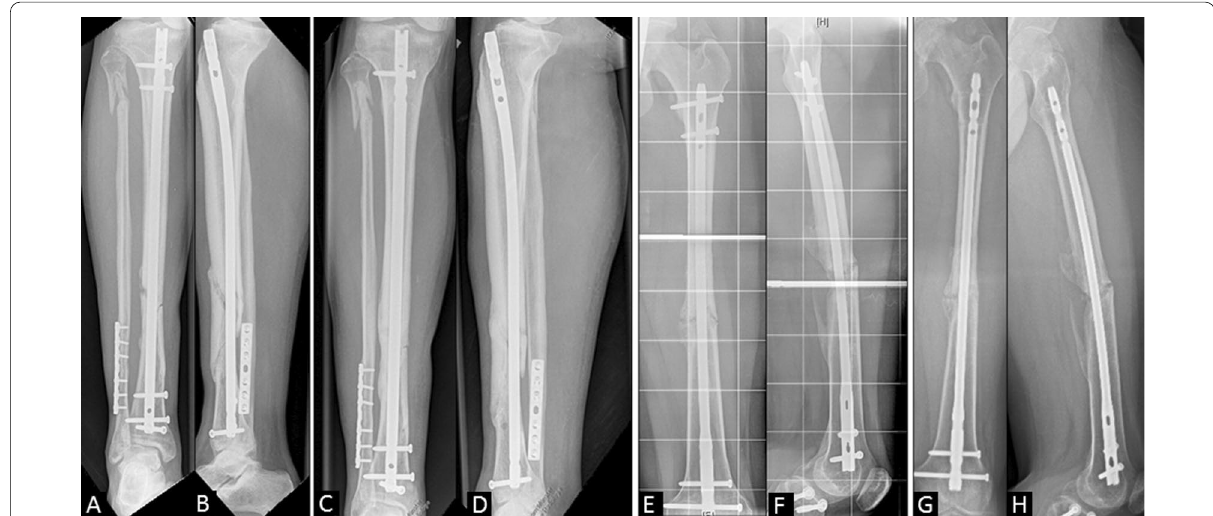
Fig. 2 A – D Serial radiographs of a 50‑year‑old patient after a II° open tibia fracture showing non‑union 8 months after primary surgery ( A , B ) and osseous union 6 months after nail dynamization and fESWT ( C , D ). E – G A 27‑year‑old patient suffered from a closed femur fracture with consecutive non‑union 1.5 years later ( E , F ). Treatment of the clinical control with nail dynamization was not successful after 6 months ( G, H